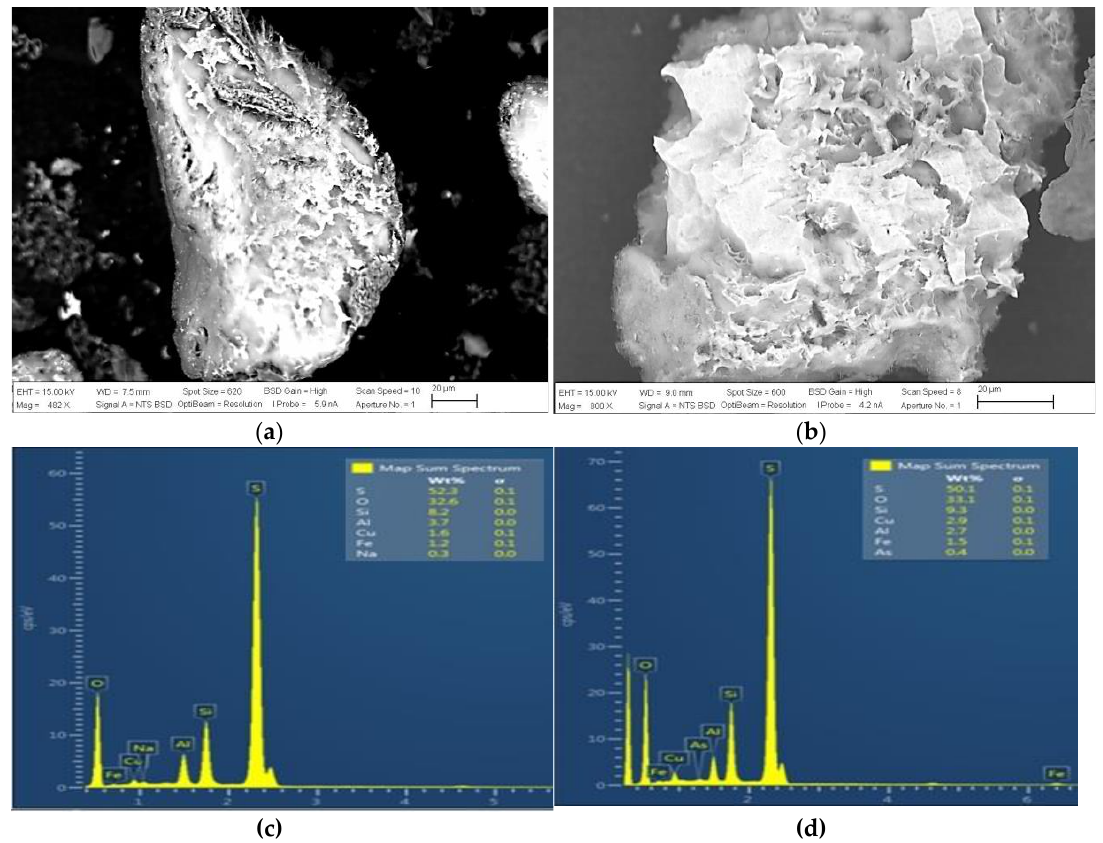
Figure 8. ( a ) SEM micrographs of chalcopyrite leached with 36 g/L chloride, Test 16; ( b ) SEM micrographs of chalcopyrite leached with 60 g/L chloride, Test 15; ( c ) EDS spectra of chalcopyrite leached with 36 g/L chloride, Test 16 (mapping) and ( d ) EDS spectra of chalcopyrite leached with 60 g/L chloride, Test 15 (mapping). Experimental conditions: [NaNO 3 ] = 0.7 M, [H 2 SO 4 ] = 0.7 M, −150 + 75 µm, S/L ratio 2 g/L, 45 °C, 350 rpm, sample A.